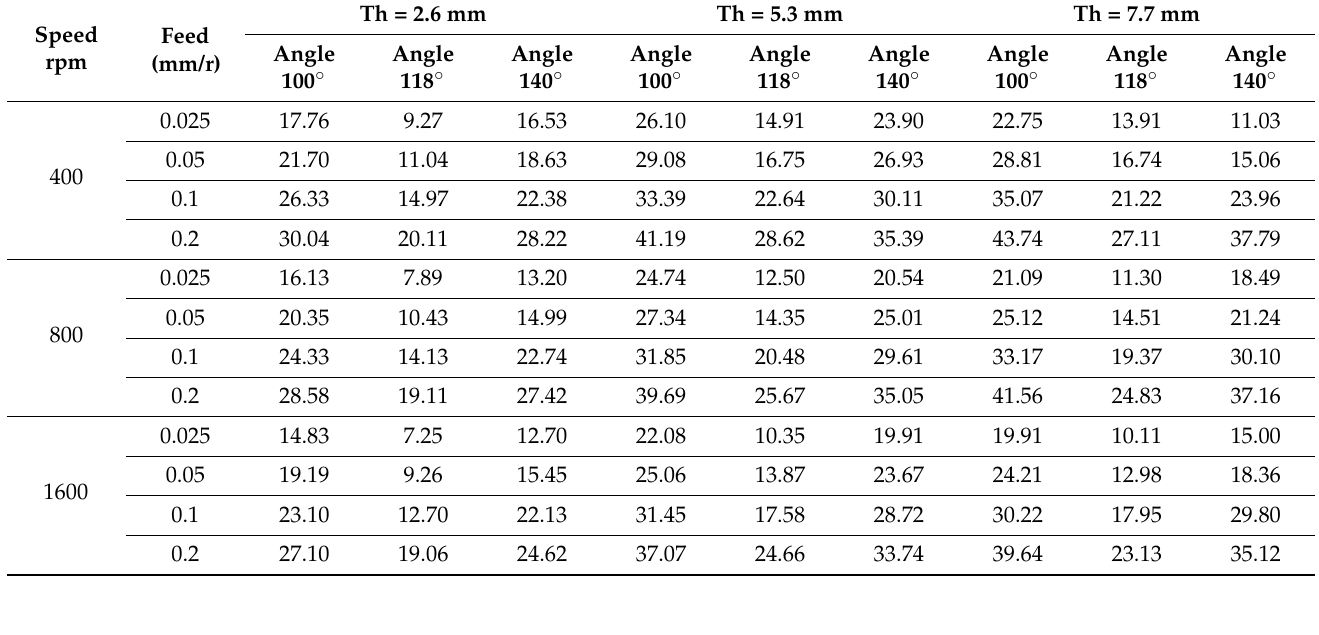
Table 8. The variation of torque with speed, feed, thickness, and point angle.